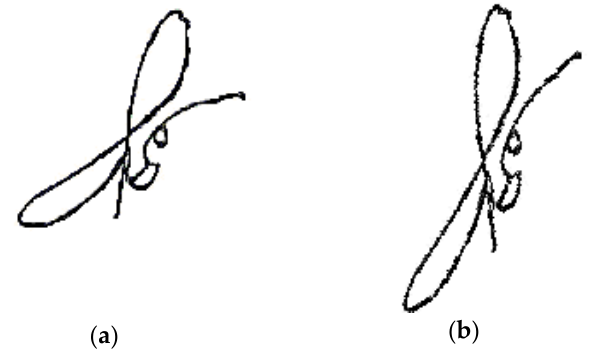
Figure 1. ( a ) The target image; ( b ) The observed image.